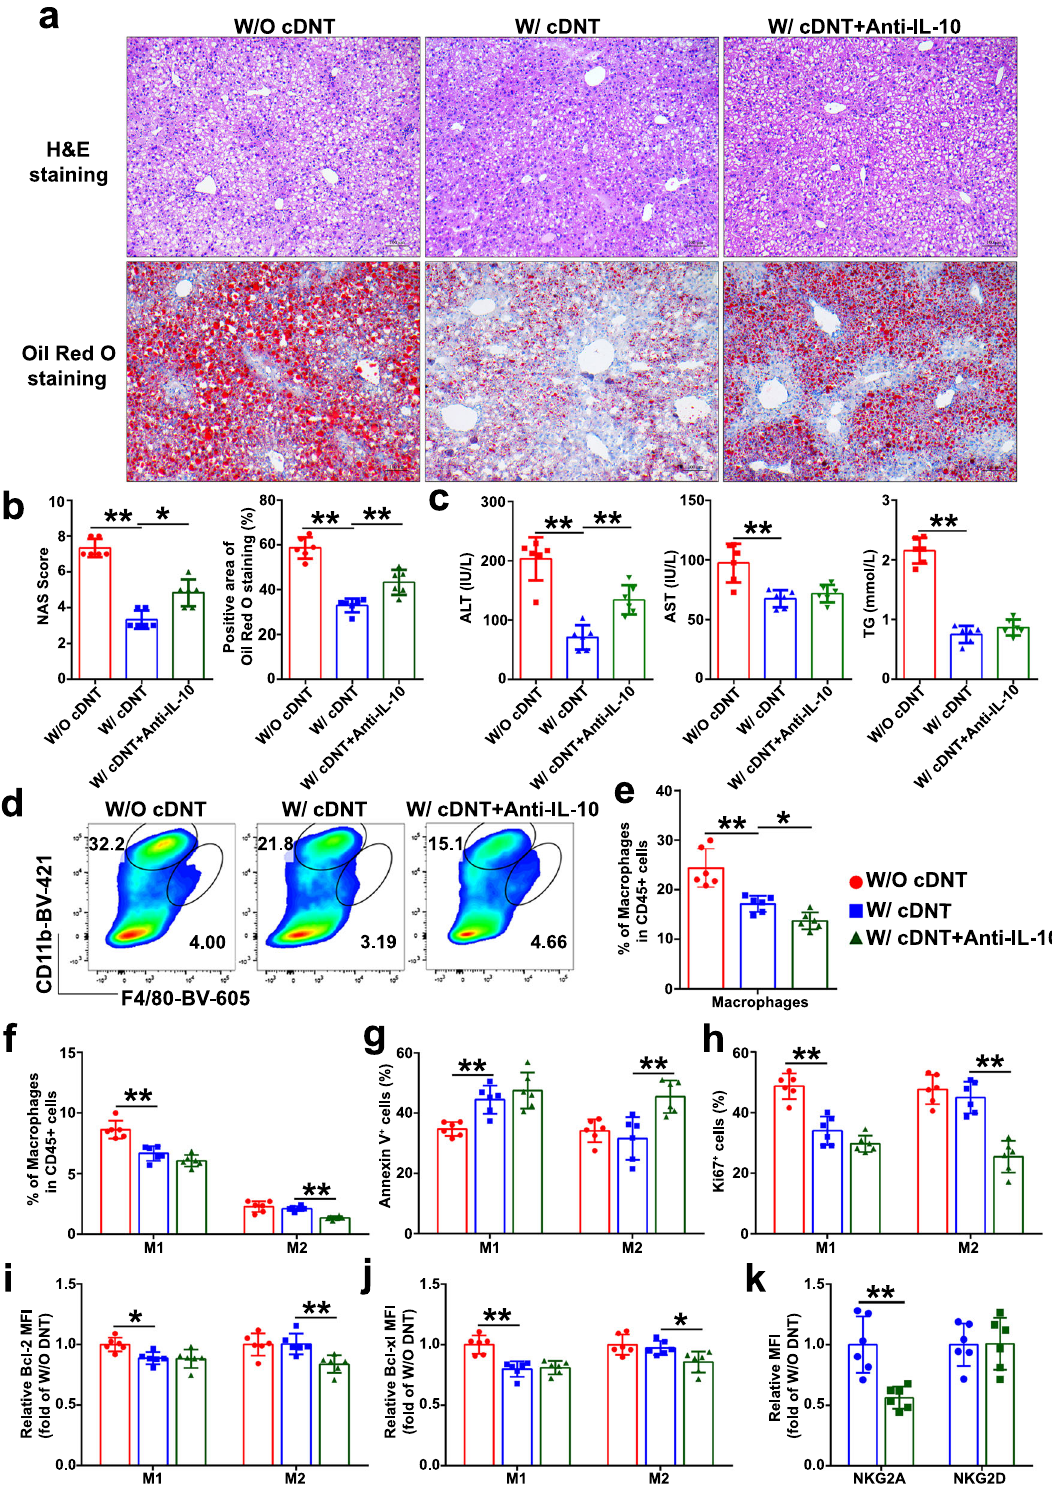
6.0 software (GraphPad Software, San Diego, CA, USA). Values are expressed as the mean± standard deviation (SD). The normal distribution of variables was tested with the Shapiro – Wilk test. Differences between two groups were compared by t test for normal variables and Kruskal – Wallis test for non-normal variables. One-way ANOVA with post hoc test for normal variables and Kruskal – Wallis test for non-normal variables were used in multiple comparisons. Two-sided p values <0.05 were considered signi fi